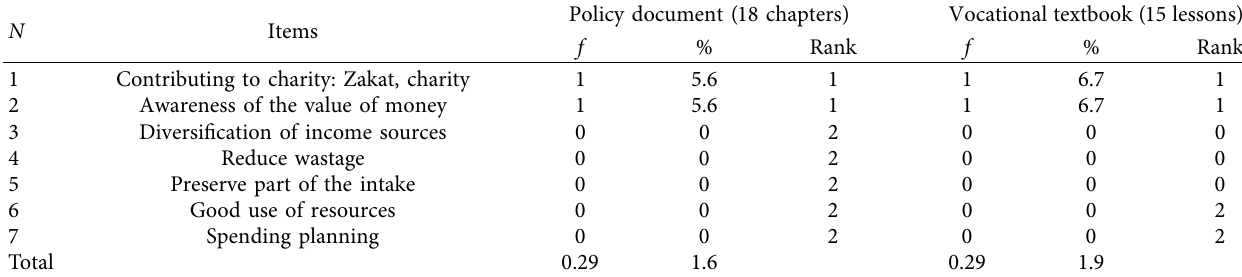
Table 2: The descending order of the economic values related to savings contained in the provisions of the vocational book and the education policy document in Saudi Arabia.